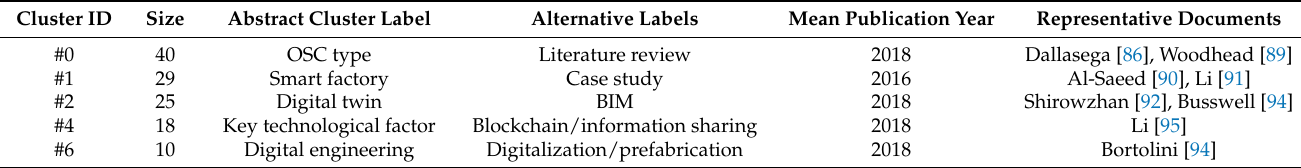
Table 9. Co-citation clusters of Industry 4.0 in construction from 2006 to